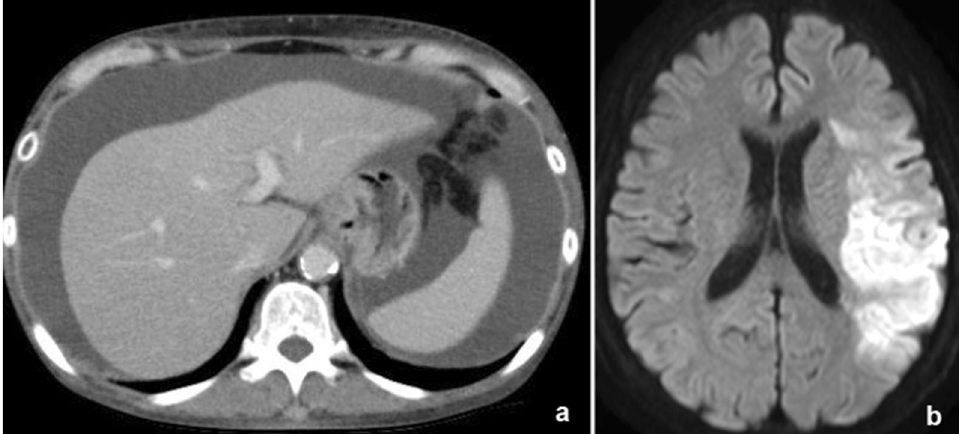
Fig. 1 Imaging findings at onset of brain infarction. a . Enhanced computed tomography image showing abundant ascites; b left brain infarction presented by magnetic resonance